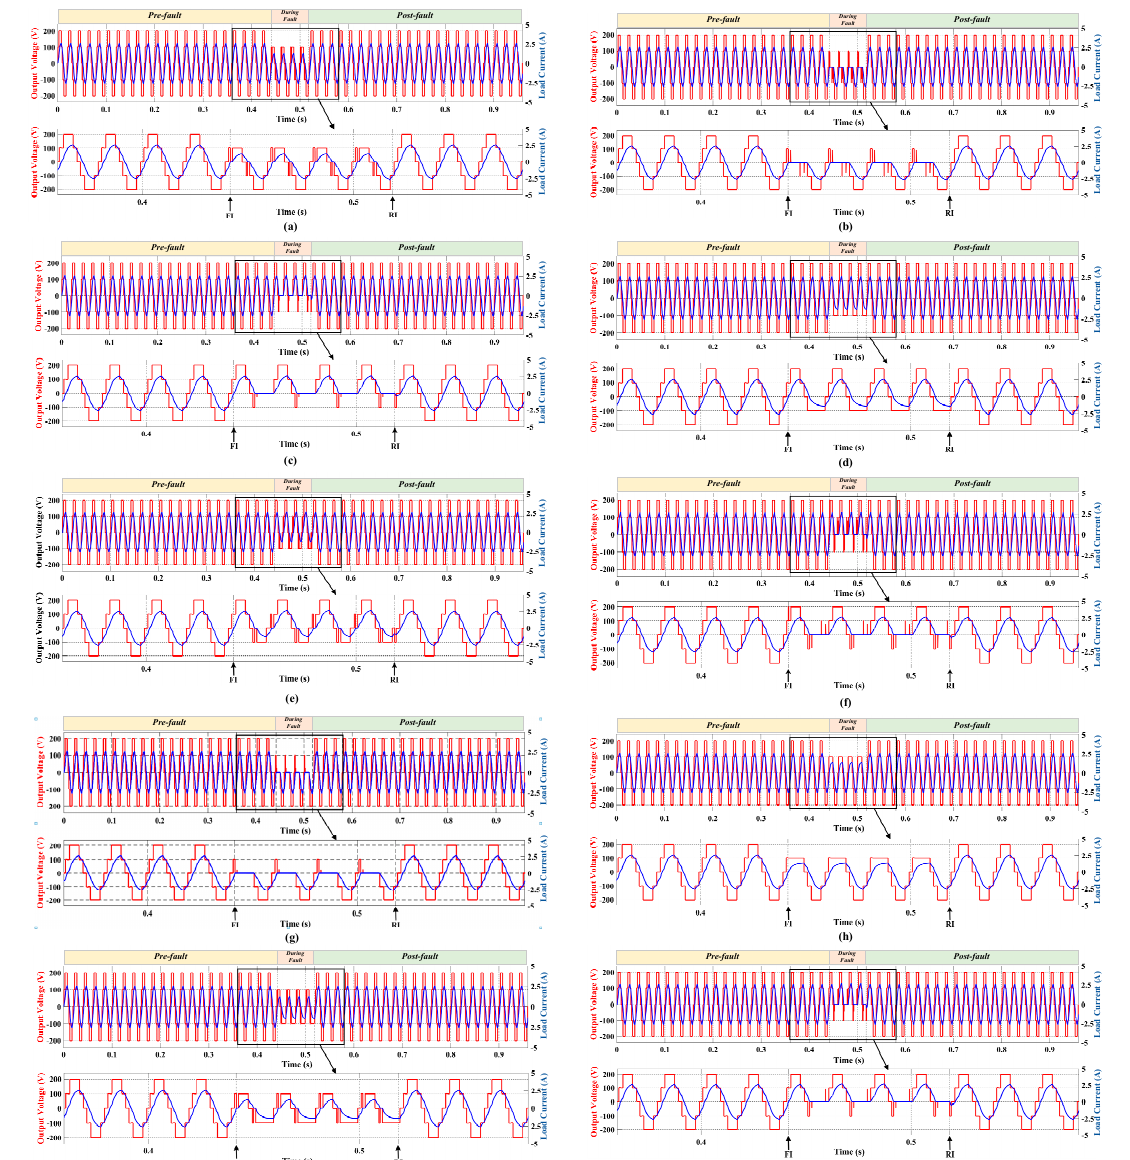
Figure 52. Simulations results (output voltage and load current) for FT operation of the topology in the case of OC single-switch fault for switch ( a ) A 1 , ( b ) A 2 , ( c ) A 3 , ( d ) A 4 , ( e ) B 1 , ( f ) B 2 , ( g ) B 3 , and ( h ) B 4 ; and OC multiple-switch fault for switches ( i ) A 1 and A 4 and ( j ) A 4 and B